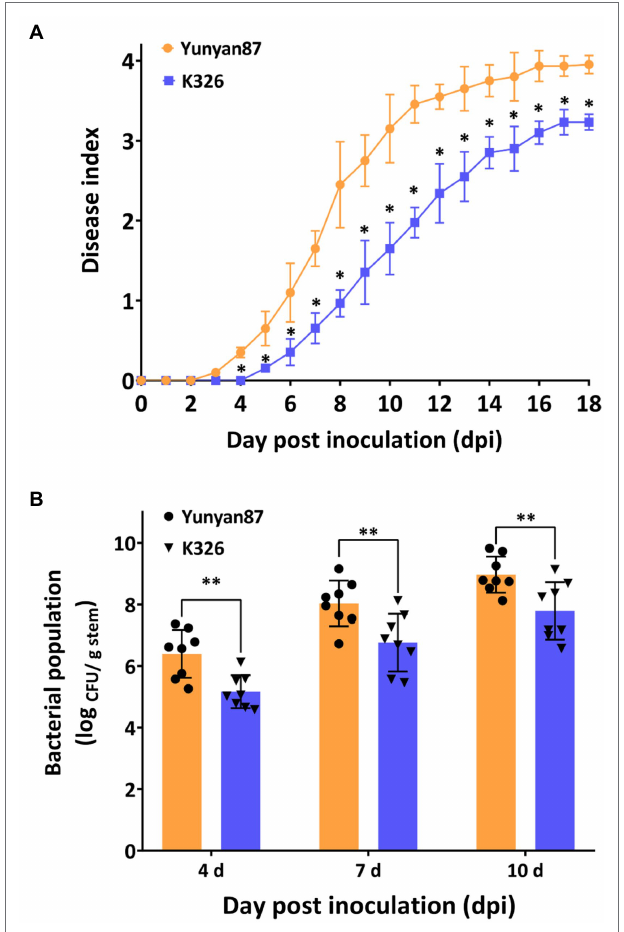
FIGURE 1 | Differential responses of tobacco cultivars Yunyan87 and K326 to R. pseudosolanacearum inoculation. (A) Bacterial wilt disease index of susceptible cultivar Yunyan87 and quantitatively resistant line K326 scored over time after soil-soak inoculation using a disease index scale from 0 to 4. (B) R. pseudosolanacearum bacterial populations in stem tissues of the two tobacco cultivars soil-soak inoculated with R. pseudosolanacearum . Each bar represents the mean ± standard error of eight experimental replicas. Asterisks indicate significant differences between tobacco cultivar Yunyan87 and K326 according to Student’s t test ( * indicates p < 0.05, ** indicates p <